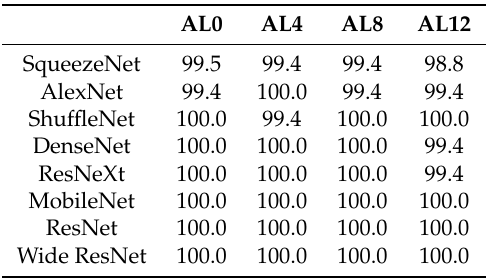
Table 4. Architecture baseline performance with underwater sets.